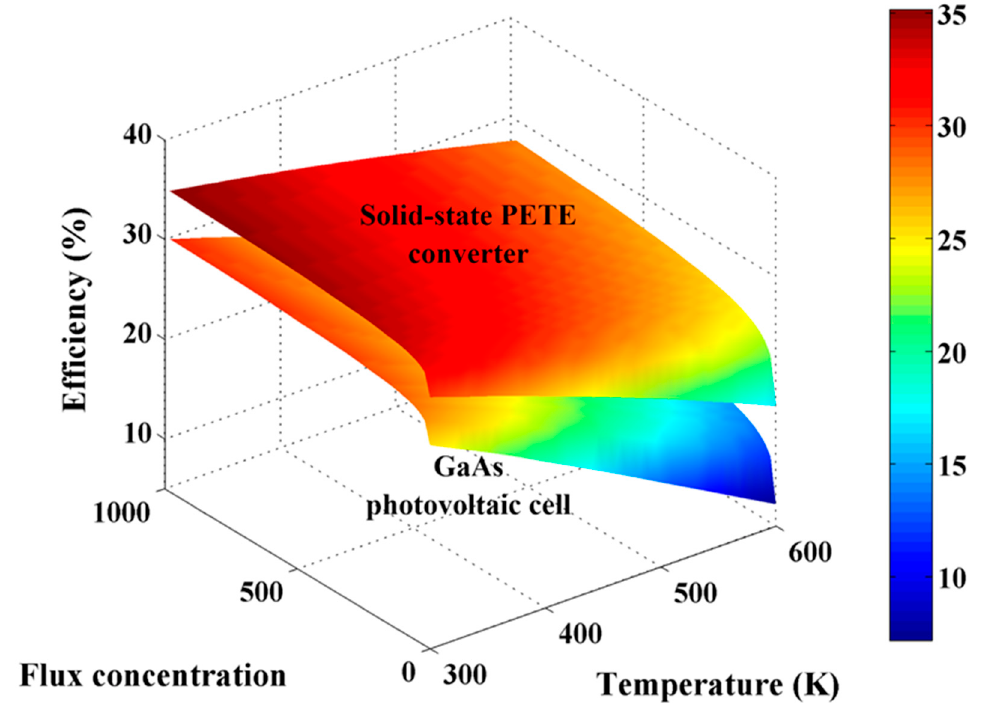
Figure 4. Efficiencies of the solid-state PETE converter with GaAs absorption layer and practical GaAs photovoltaic cell as functions of operating temperature and flux concentration of incident solar radiation.